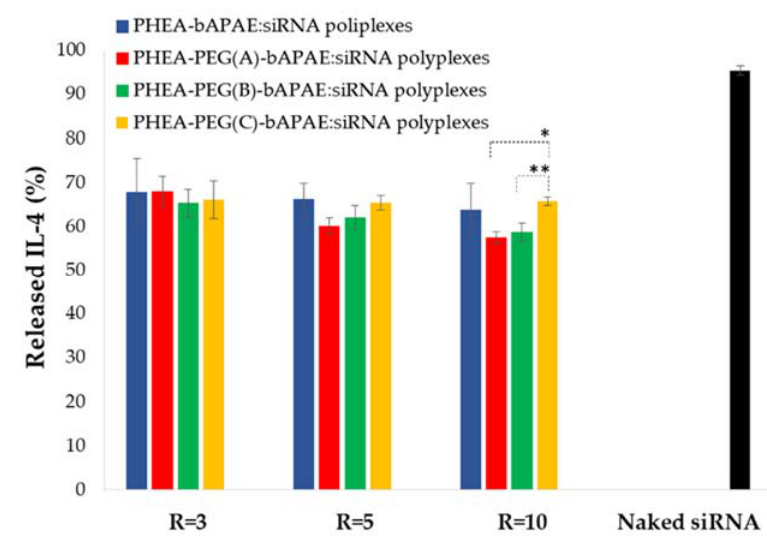
Figure 14. IL-4 (%) released by 16-HBE cells after incubation with polyplexes or with naked siRNA for Figure 14. IL ‐ 4 (%) released by 16 ‐ HBE cells after incubation with polyplexes or with naked siRNA 48 hrs, compared to positive control. (* p < 0.01; ** p < for 48 hrs, compared to positive control. (* p < 0.01; ** p < 0.001).